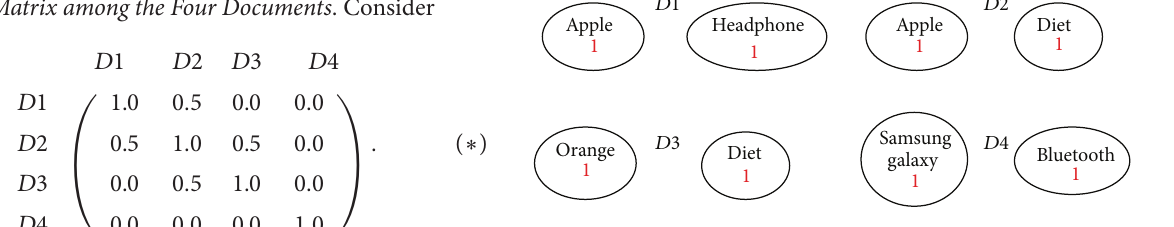
Figure 2: Initializing the graphs for the four